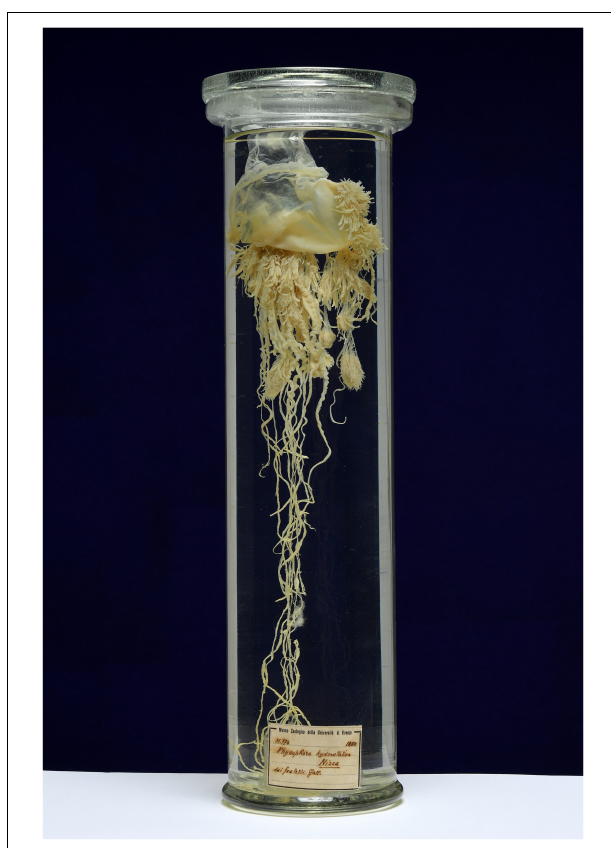
FIGURE 2 | The colony of P. physalis collected in Mediterranean French waters (Nice) in 1850, voucher code MZUF-uncatalogued, preserved at the Natural History Museum of the University of Florence (photo ©Saulo Bambi, Museo di Storia NaturaleUniversitàdeglistudi di Firenze). FIGURE 3 | The two colonies of P. physalis collected in the Gulf of Naples